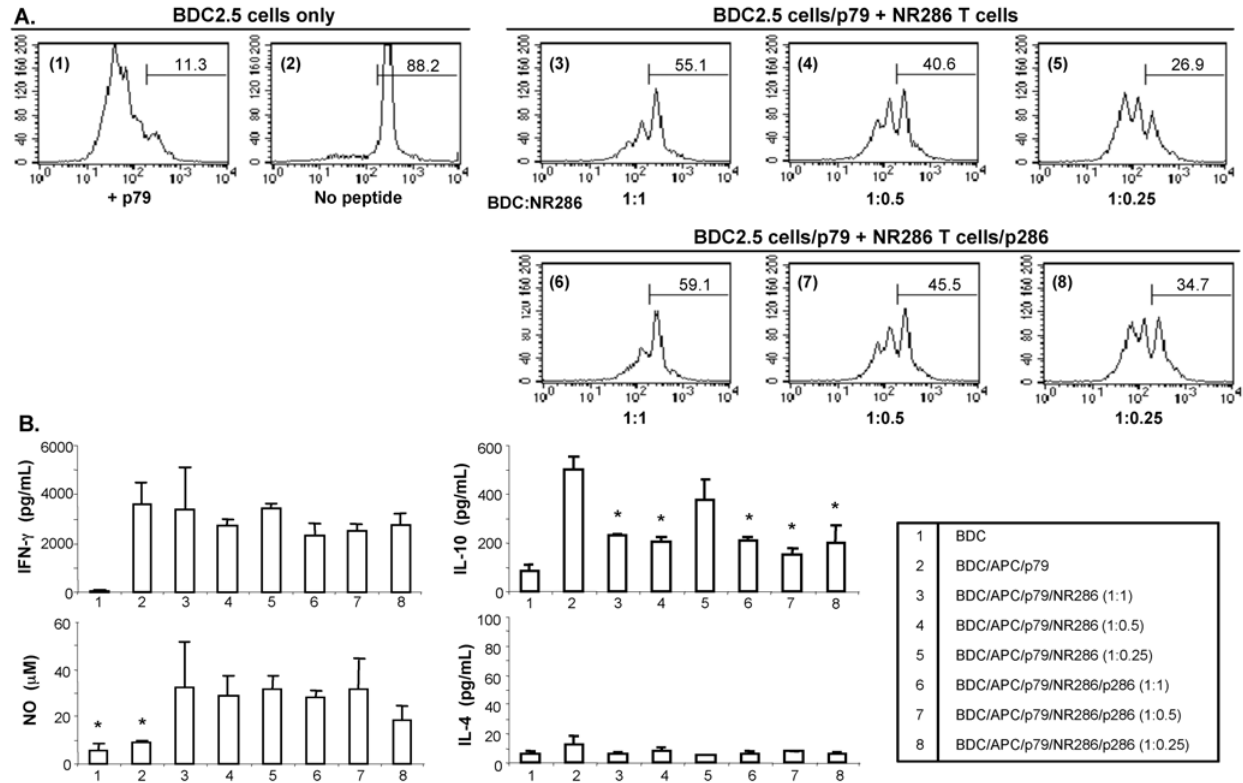
Figure 4. NR286 T cells suppress proliferation of BDC2.5 T cells. ( A ) Inhibition of CFSE-labeled BDC2.5 T cell proliferation co-cultured with NR286 T cells. CD4 + BDC2.5 T cells were isolated from BDC2.5 TCR transgenic mice and labeled with CFSE (2 6 10 5 /well), then cultured under eight different conditions (indicated as the numbers in parenthesis shown in each histogram). In control cultures, BDC2.5 T cells were cultured alone either (1) without p79 or (2) with p79 (0.1 m g/ml) plus CD4 + cell-depleted irradiated APCs from NOD mice. Cells also were co-cultured in the presence of either NR286 T cells (conditions 3–5) or with NR286 T cells plus p286 (conditions 6–8) for 4 days. NR286 T cells were added to cell cultures with a 2- fold serial dilution starting at a 1:1 ratio (BDC2.5 T cells: NR286 T cells). The numbers shown in each histogram represent the percentage of cells that underwent , 2 rounds of cell division. Data are representative from at least n=3. ( B ) Cell culture supernatant was harvested from 4-day cell cultures under the same eight different conditions as shown in ( A ). Levels of IL-10 detected in conditions 3, 4, and 6–8 were significantly reduced compared to condition 2 (p , 0.01). NO production in conditions 3–8 was significantly increased compared to conditions 1 and 2.